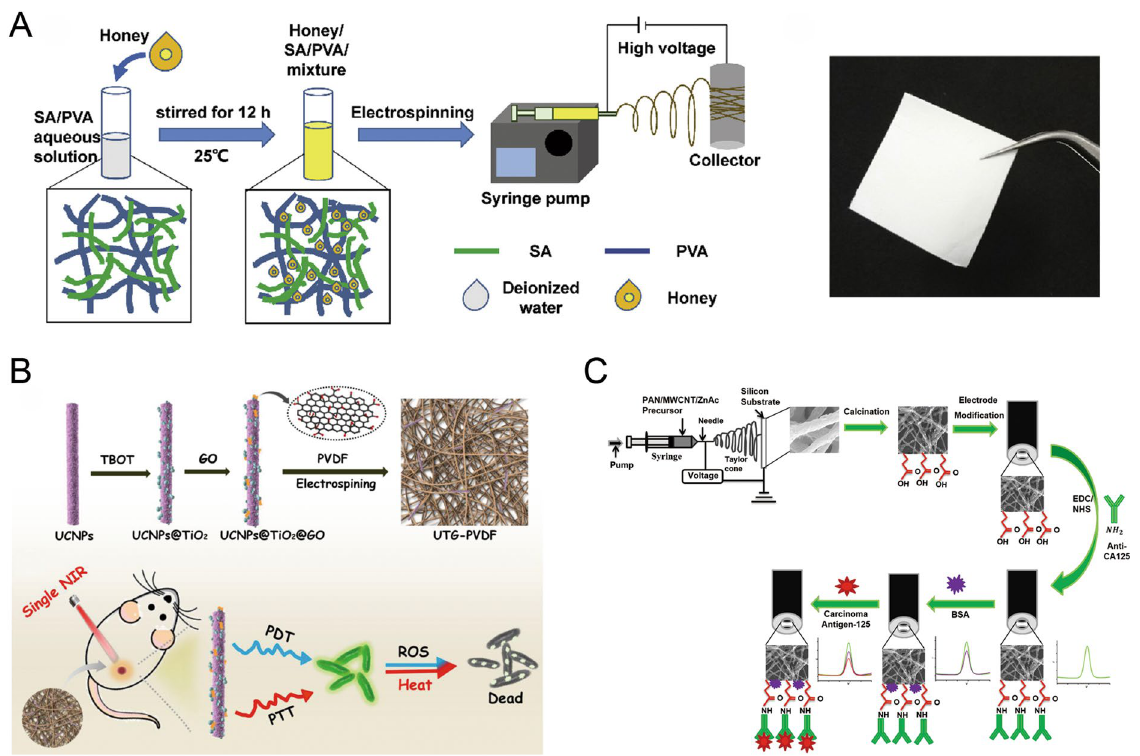
Reprint with permission from American Chemical Society; c Con- struction of carcinoma antigen-125 immunosensor and schematic diagram of action principle [104].